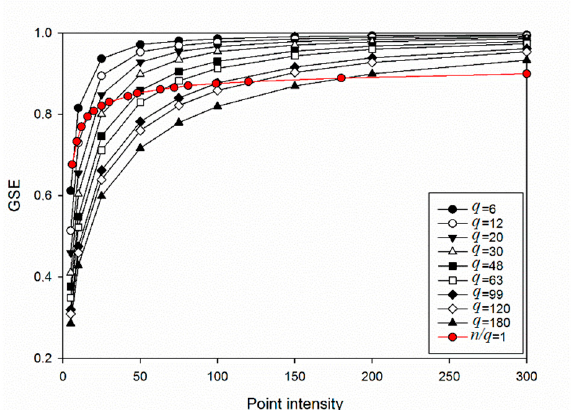
Figure 3. Dependency of the Global Shannon Entropy (GSE) metric on point intensity ( n i ) and number of quadrats ( q ).